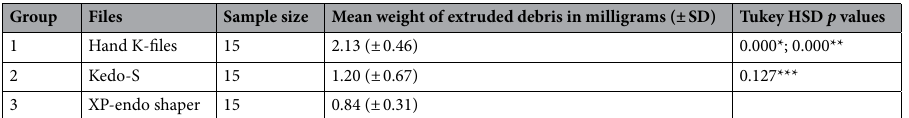
Table 1. Analysis of variations in the mean weight of apically extruded debris using three different file systems. *Comparison between Hand K-files and Kedo-S, **Comparison between Hand K-files and XP-endo Shaper, ***Comparison between Kedo-S and XP-endo Shaper. P value of less than 0.05 was considered as statistically significant.